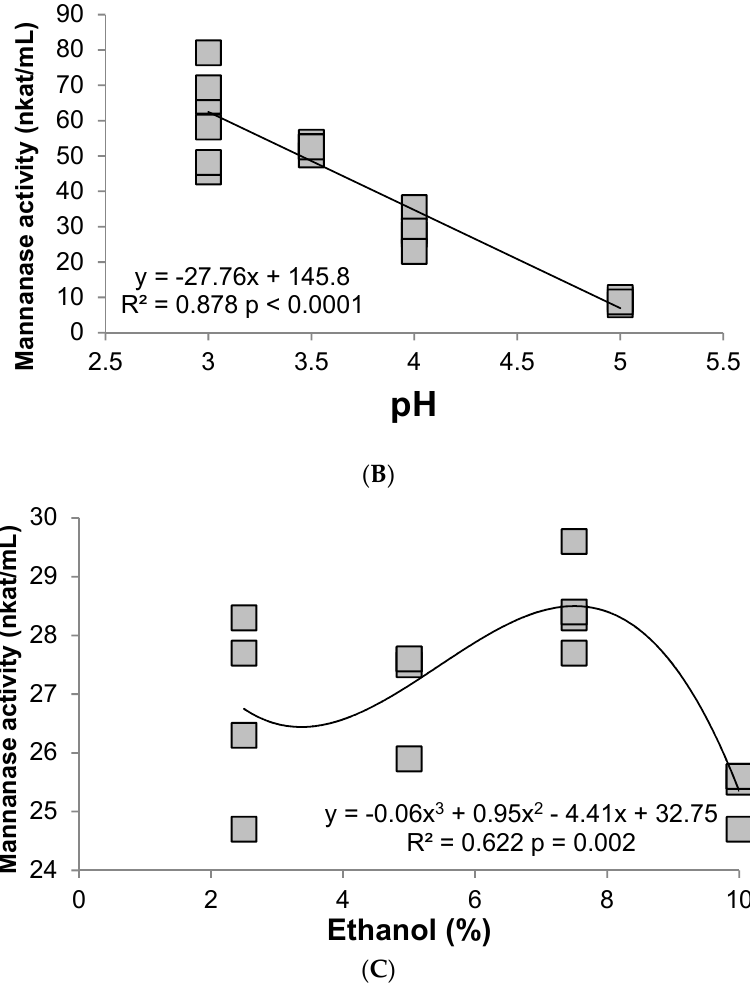
Figure 4. Scottzyme Color X β -mannanase (hemicellulase) activity on azo-carob galactomannan, measured in sodium acetate buffer solution. ( A ) Impact of temperature (pH = 3.5; ethanol = 0%); ( B ) Impact of pH (temperature = 30 °C; ethanol = 0%); ( C ) Impact of ethanol (pH = 3.5, temperature = 20 °C).